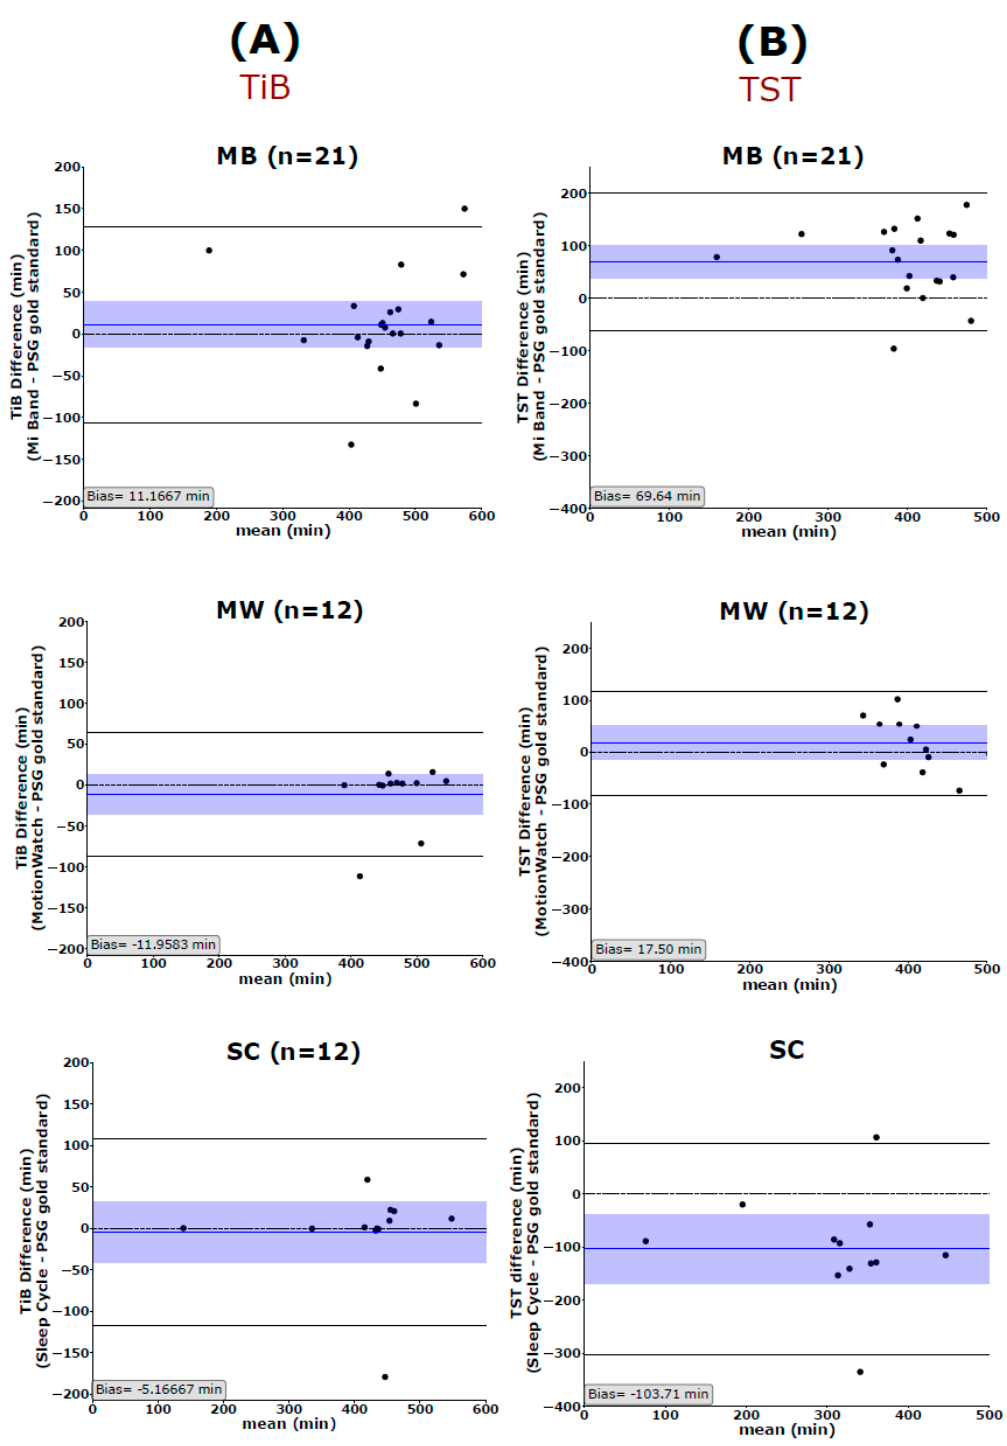
Figure 1. Bland–Altman plots show the agreement of Mi Band (MB), MotionWatch (MW), and Sleep Cycle (SC) with the polysomnography (PSG) in measuring ( A ) time in bed (TiB) but not ( B ) total sleep time (TST). The blue horizontal line represents the mean difference between the two measurements, and the shaded blue area represents the 95% CI of the mean difference. Black horizontal lines mark the 1.96 SD from the mean. The black dashed line is the line of equality (difference = 0). TiB: time in bed, TST: total sleep time, MB: Mi Band, MW: MotionWatch, and SC: Sleep Cycle application.